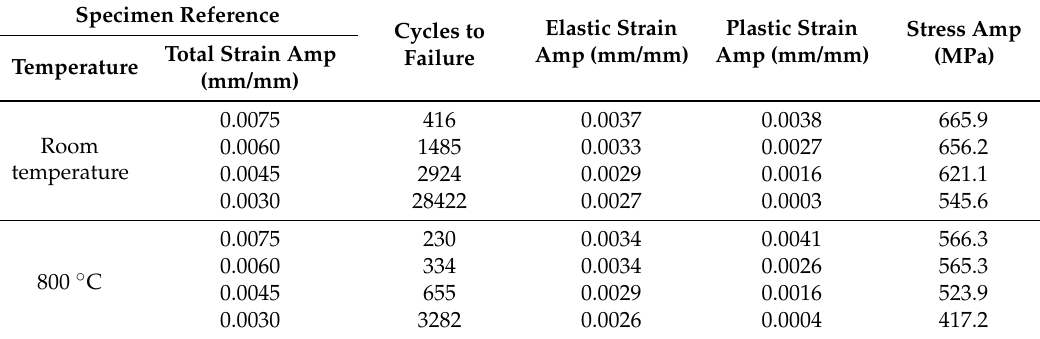
Table 3. Summary of LCF tests results of Alloy 617